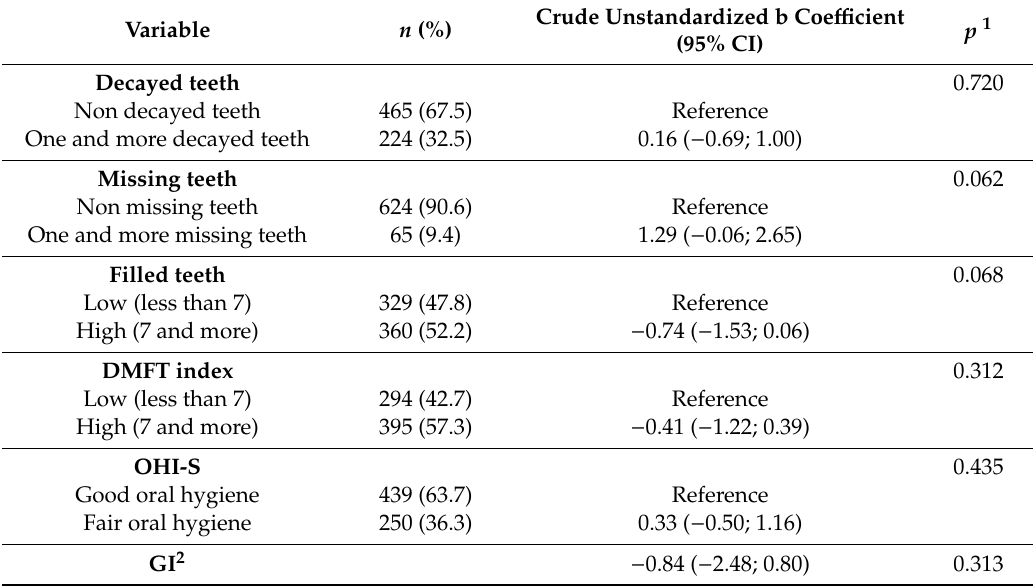
Table 4. Clinically assessed oral health associated with perceived stress in the study